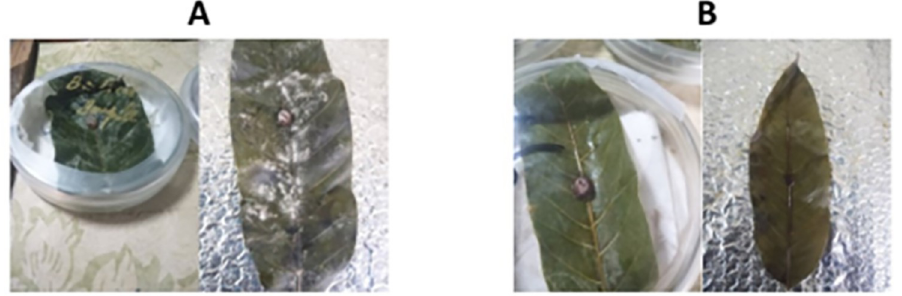
Fig 12. In vitro leaflet assay of green synthesized SeNPs against Fusarium mangifera .